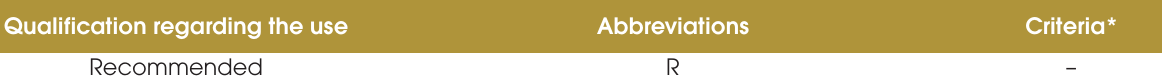
Table 8 – Abbreviations used to qualify prediction models in code regarding its use Qualification regarding the use